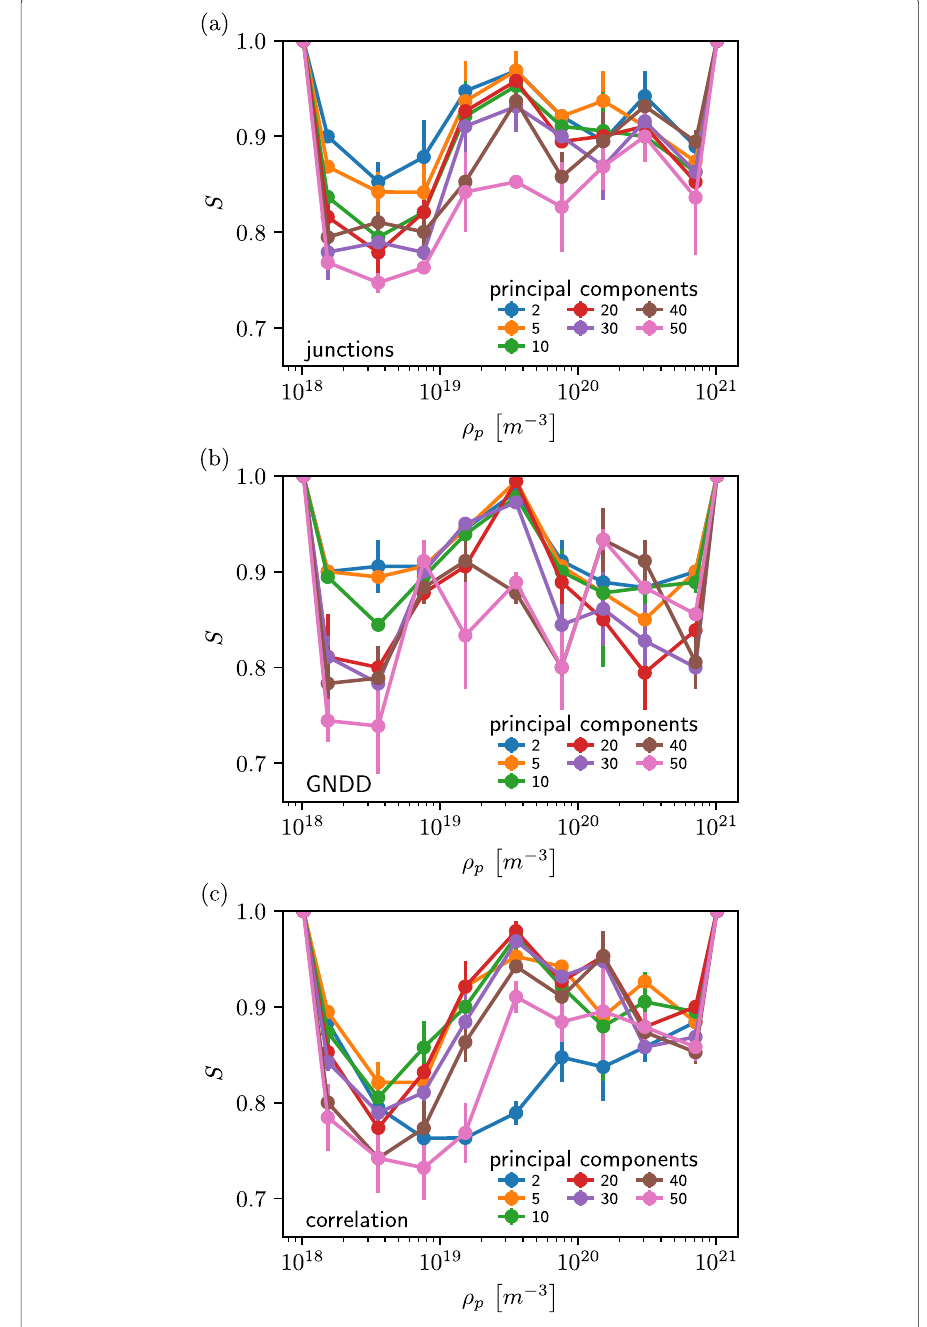
Fig. 6 The confusion curves with different number of principal components. Used features are a junction lengthening, b GND density change, and c dislocation correlation during the simulation time